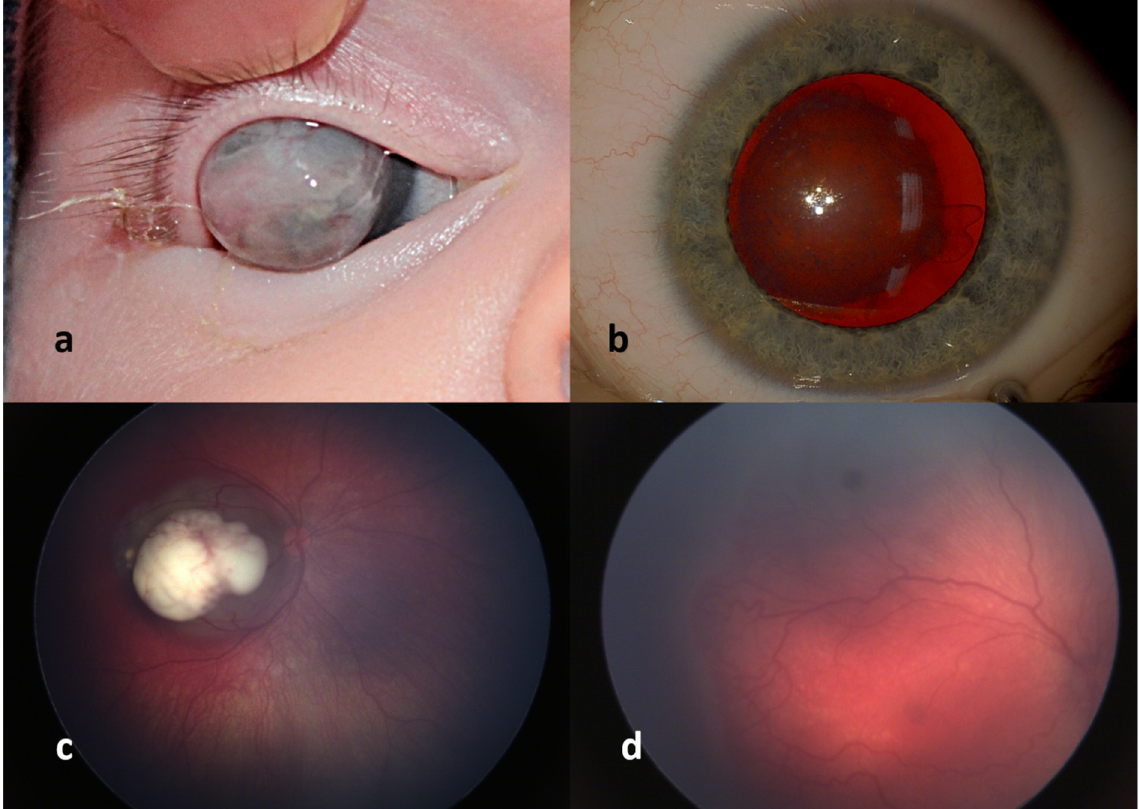
Figure 1. Examples of ocular diseases in infants: corneal dysgenesis ( a ), congenital cataract ( b ), early diagnosed Group B intraocular retinoblastoma ( c ), retinopathy of prematurity stage 2 in zone I and posterior zone II with plus disease ( d ).